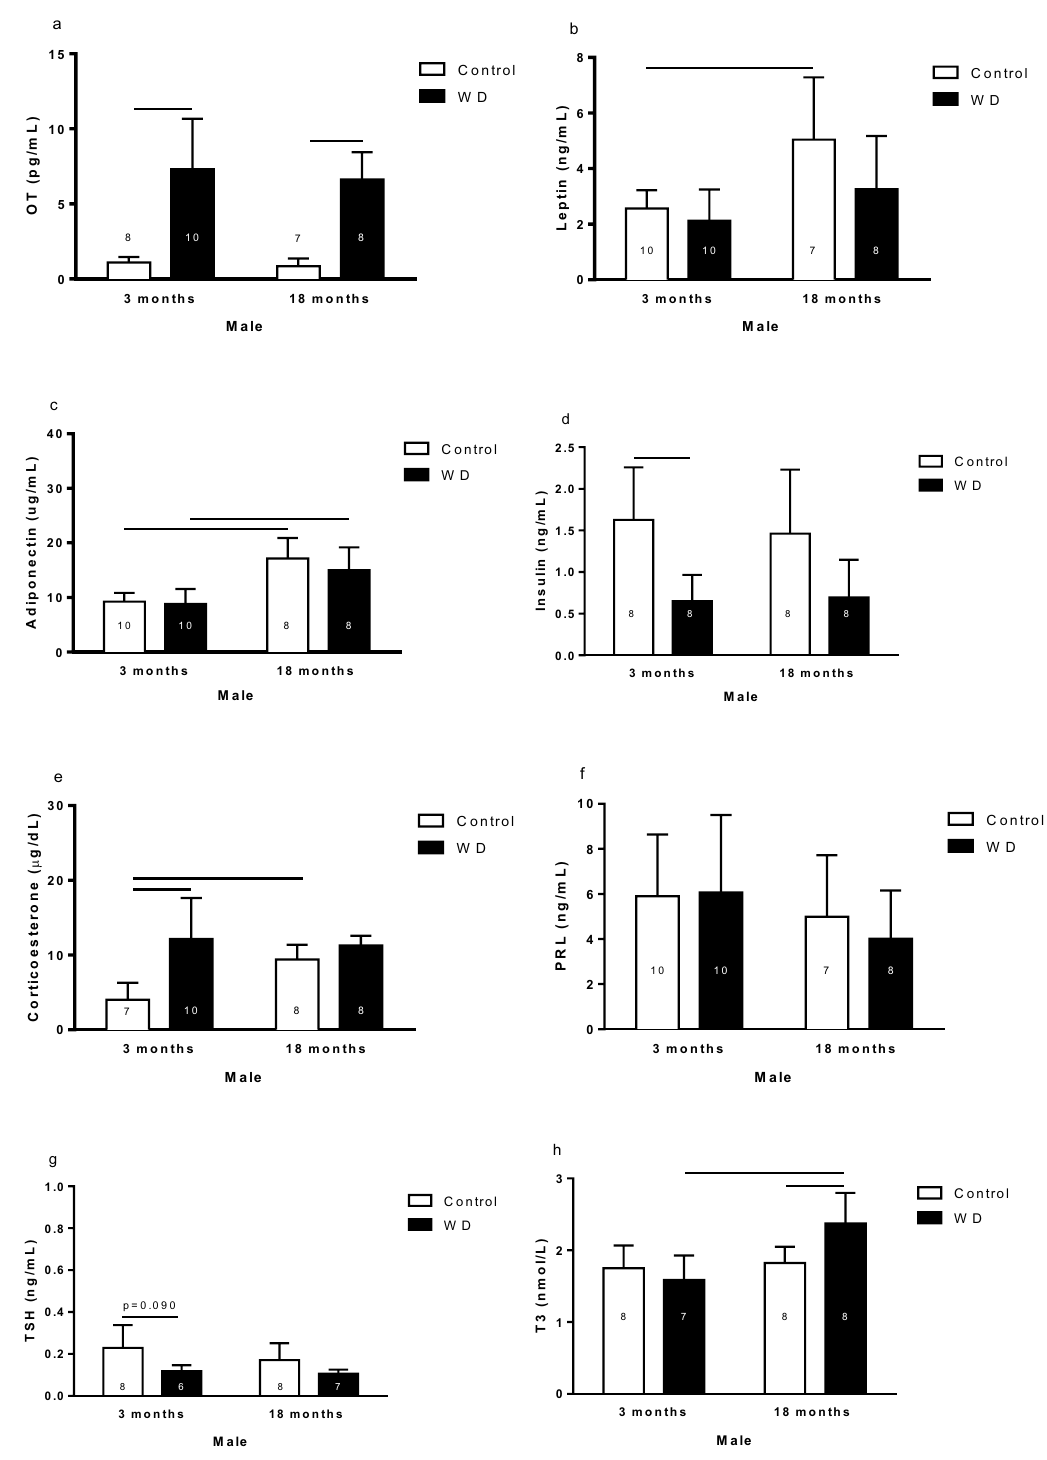
Figure 2. Oxytocin ( a ), leptin ( b ), adiponectin ( c ), insulin ( d ), corticosterone ( e ), prolactin ( f ), thyroid stimulating hormone (TSH) ( g ), and triiodothyronine ( h ) plasma concentration of 3- and 18-month-old male control and rats with water deprivation (WD). Data are presented as means (SD), p < 0.05 among the indicated groups. Two-way ANOVA followed by Newman-Keuls post-test when variances were equal, and Games-Howell when variances were different. The n for each group is inside or above the